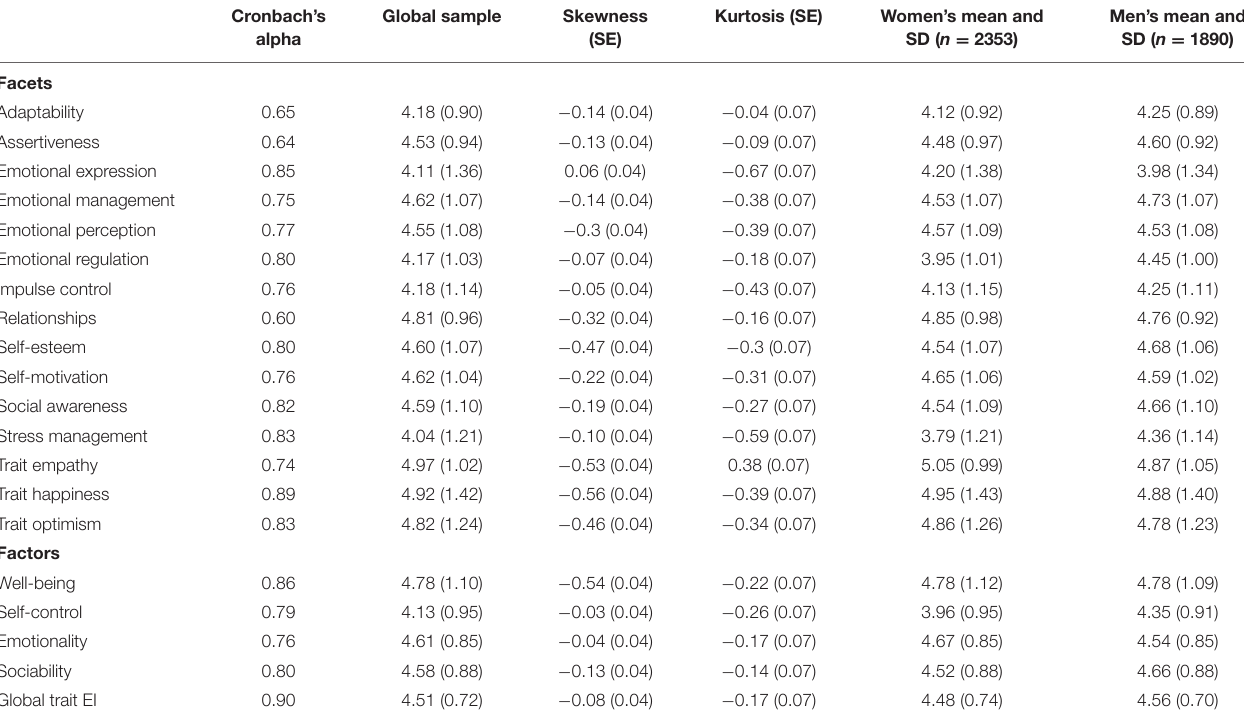
TABLE 3 | Descriptive statistics (means and standard deviations) for the TEIQue